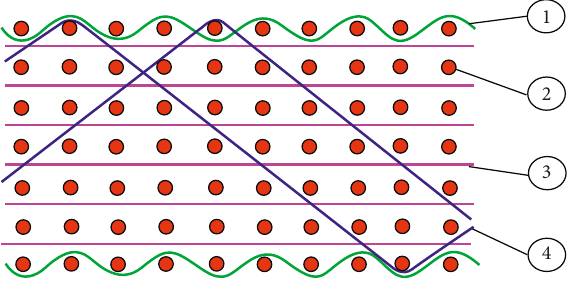
Figure 2: Schematic view of a 3D warp interlock